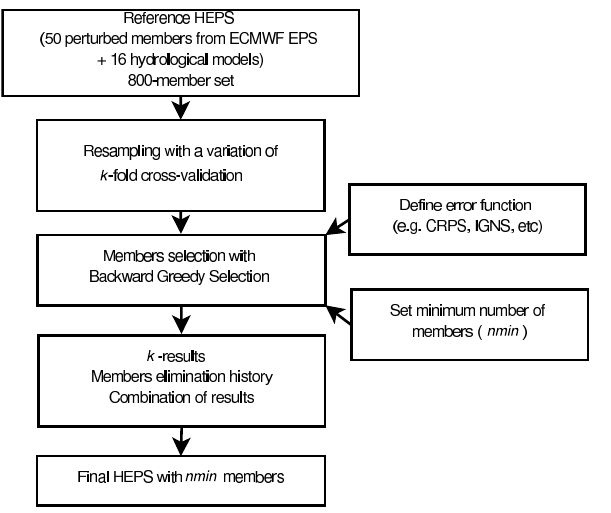
Fig. 1. Hydrological members’ selection methodology.